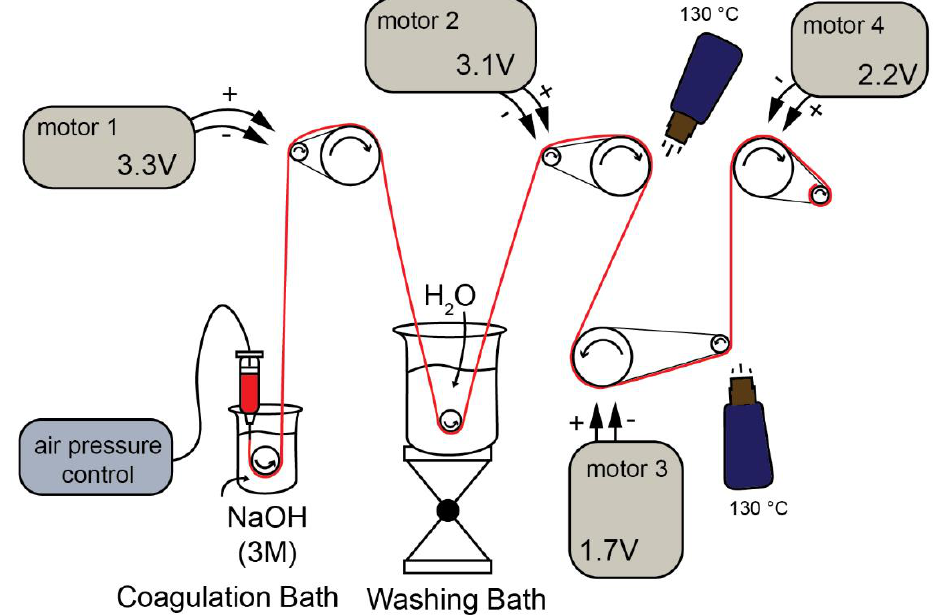
Figure 1. Schematic illustration of the wet/gel spinning setup to achieve nanocomposite fiber yarns of chitosan (CHI) filled with cellulose nanofibers (CNF). Table 1. Linear speed of the roller bobbins integrated into the spinning motors. Motor